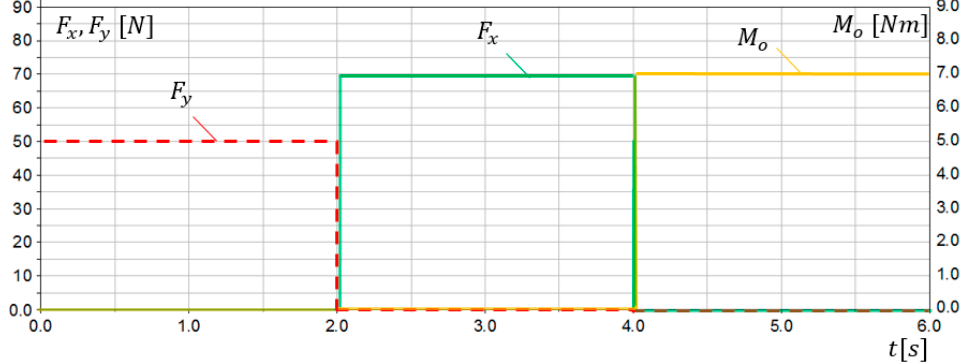
Figure 12. Simulation research results for the sensory grip–characteristics of input loads F y , F x , M o .